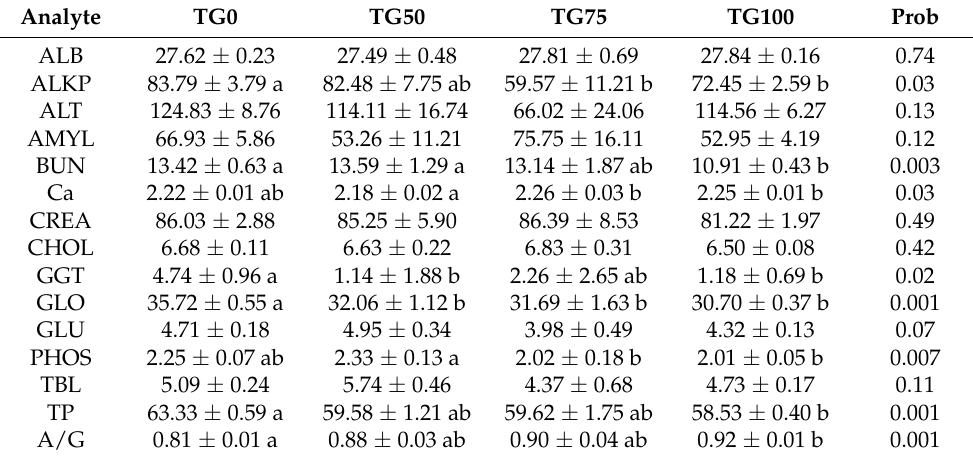
§ Means followed by different letters in rows are different at p < 0.05. ¥ In this and other tables, probabilities and mean comparisons are based on the results of the analysis of variance of the transformed data, and back- transformed least-squares means. Table 4. Least-squares means ± standard errors of the original serum analytes for the tolerant groups and the significance levels of differences among means (Prob) §